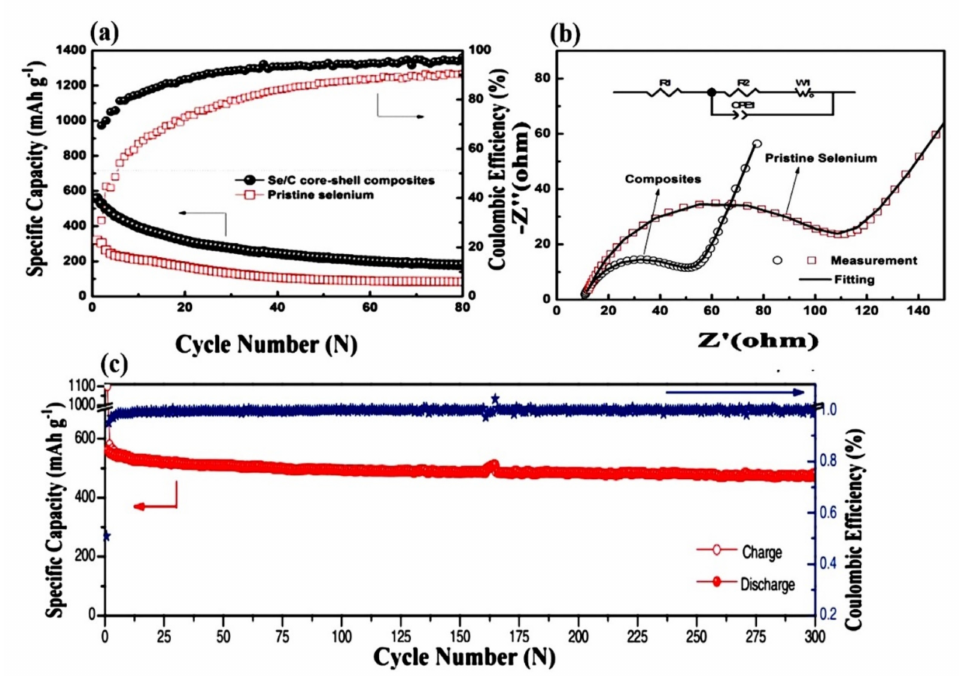
Figure 7. ( a ) Cyclability and coulombic efficiency of the Se/carbon-rich core–shell composites and the pristine selenium at the current density of 337.5 mA g − 1 , ( b ) Impedance plots and equivalent circuit for the Se/carbon-rich core–shell composites and the pristine selenium before cycling. Reproduced with permission from [61], Copyright 2015, Elsevier BV. ( c ) Cyclability of Se–NCMC at 135 mA g − 1 (0.2 C). Reproduced with permission from [64], Copyright 2018, Wiley Online